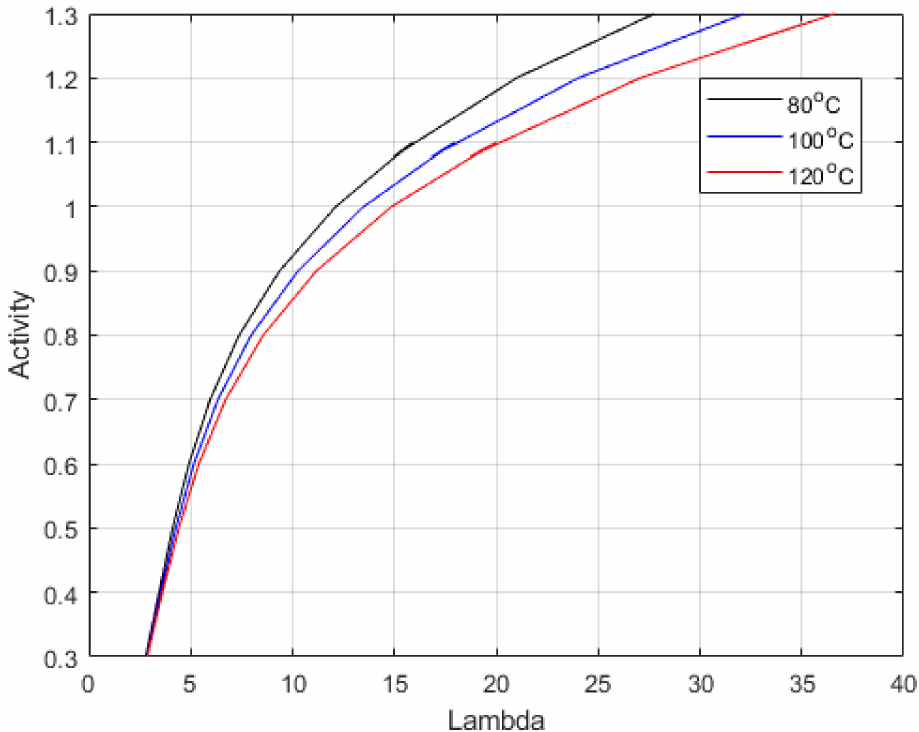
Figure 5. Predicted Lambda vs. water activity (a) from Equation (23) at varied temperatures.